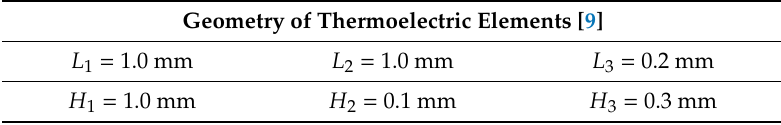
Table 2. Geometry structure of thermoelectric elements.